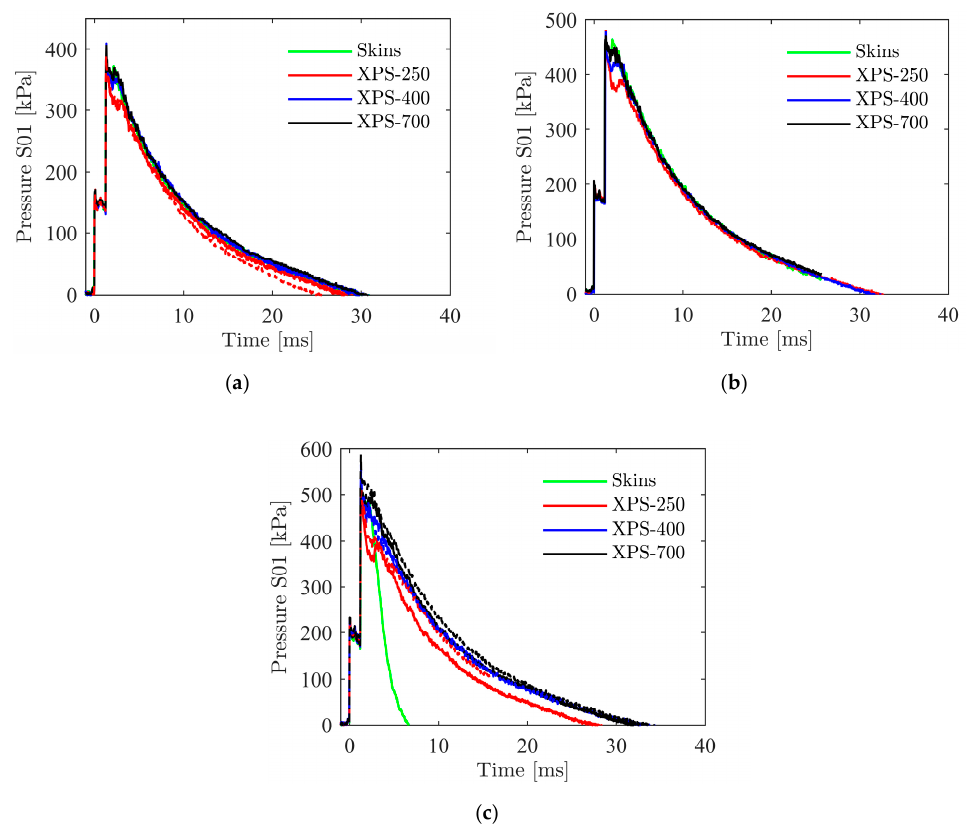
Figure 12. Measured pressure in sensor 1 for the aluminium skins only and the sandwich panels at ( a ) 10 bar firing pressure, ( b ) 12 bar firing pressure and ( c ) 15 bar firing pressure. Solid and dashed lines are used for series 1 and 2, respectively.